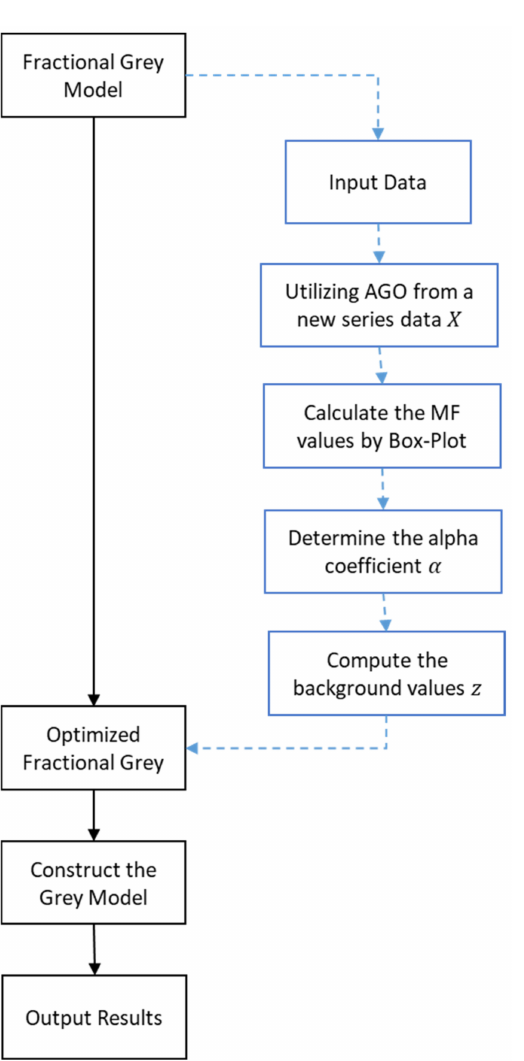
Figure 6. Flowchart of the BP-FGM